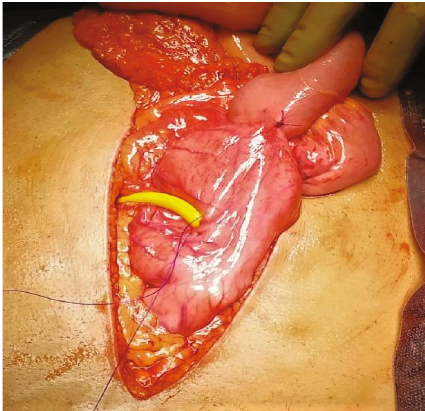
Figure 2: Two small holes, one in the center of the purse string suture (PDS 2-0) used to secure the tube after inserting it in the stomach and the other in the anterior abdominal wall, lateral to the left rectus muscle, are via electrodiathermy accomplished. A No. 18 Foley catheter is advanced through the anterior abdominal wall and into the body of the stomach, in a caudal direction. 3ml of saline is used to in fl ate the Foley balloon so that it would not slip out of the stomach (we de fl ate it on the fi rst postoperative day).